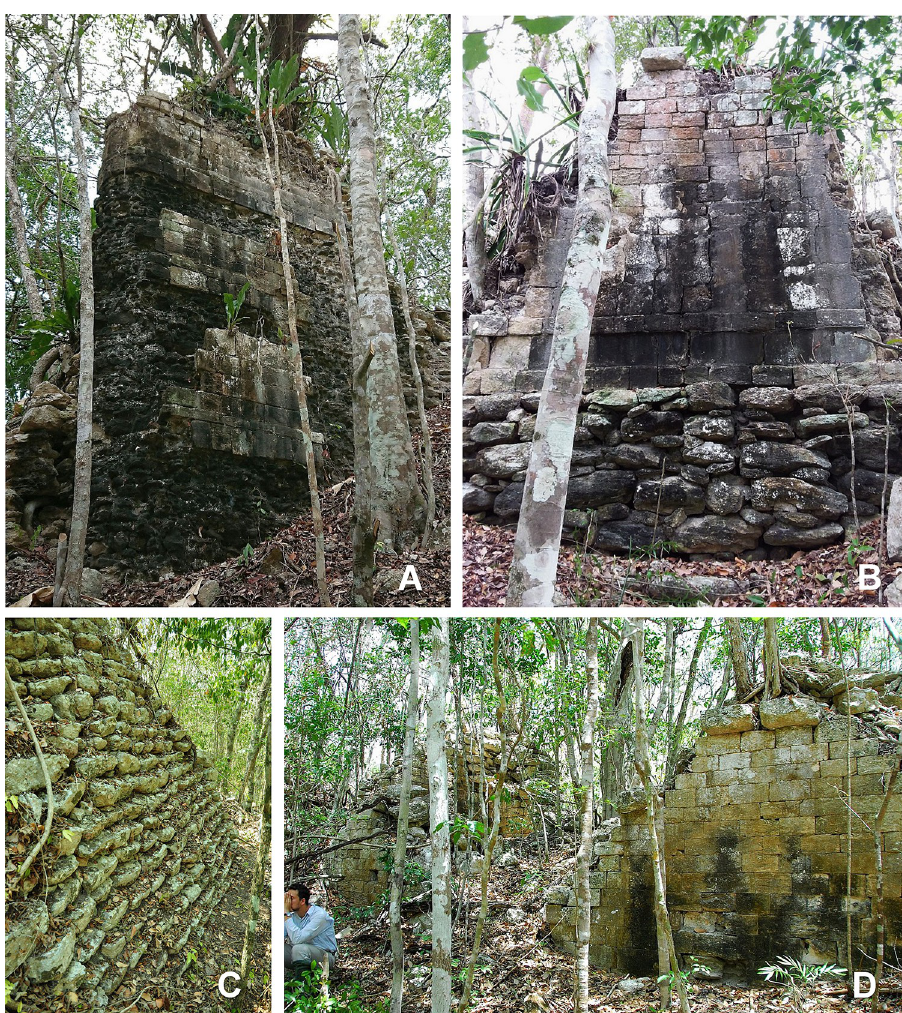
Fig 7. Architectural characteristics: two-tower building in group H31-e, west tower, looking northeast (A); northernmost building of group E19-b, north face with basal molding (B); stepped slope of a pyramidal structure in group K24-b (C); two-tower building in group D23-b, looking northeast (D).